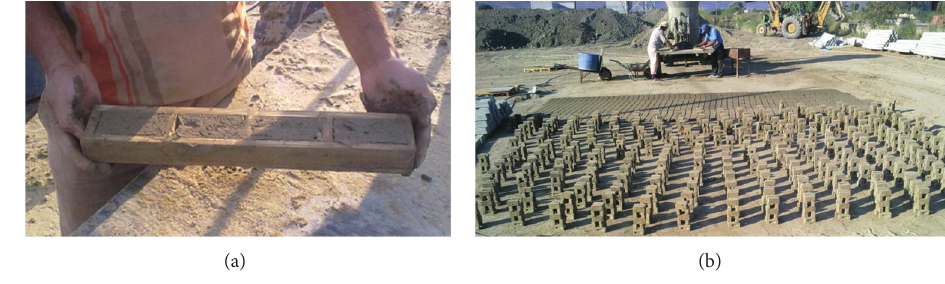
Figure 1: The masonry bricks dried under the sun.